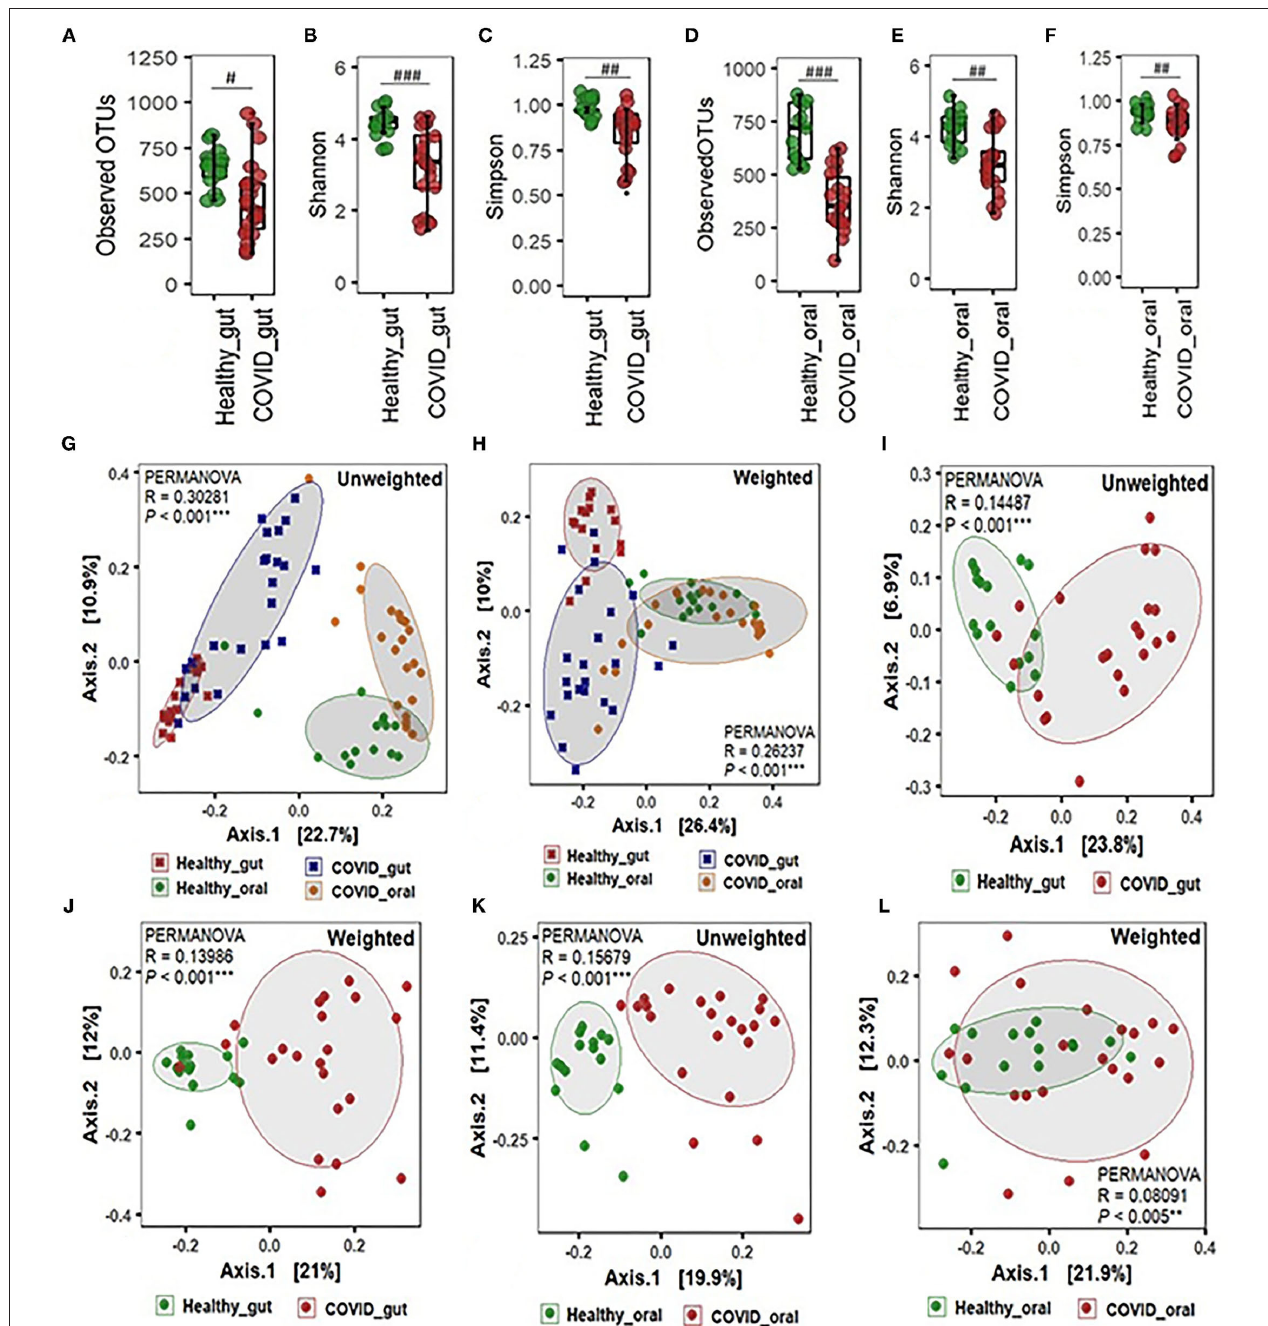
FIGURE 2 | Alpha-beta diversity of microbiota in the gut and oral wash of healthy controls and COVID-19 cases. (A–F) α -Diversity measurements of the gut and oral microbiota in terms of observed operational taxonomic units, Shannon, and Simpson index, respectively. (G) Unweighted (presence-absence) and (H) weighted (relative abundance) UniFrac metric for the gut and oral microbiota of healthy control and COVID-19 cases. (I) Unweighted and (J) weighted UniFrac metric for the gut microbiota of healthy control and COVID-19 cases. (K) Unweighted and (L) weighted UniFrac metric for the oral microbiota of healthy control and COVID-19 cases. # Significantly different at alpha-level of 0.05. ## Significantly different at alpha-level of 0.005. ### Significantly different at alpha-level of 0.001. ** Significantly different at alpha-level of 0.005. *** Significantly different at alpha-level of 0.001. with COVID-19 having diarrhea, and medication had a minor (LoM) before SARS-CoV-2 infection, compared to patients effect on these Gram-negative copathogens of with motion and healthy controls ( Table 1 ). Escherichia and Shigella were identified as a signature bacterium in patients